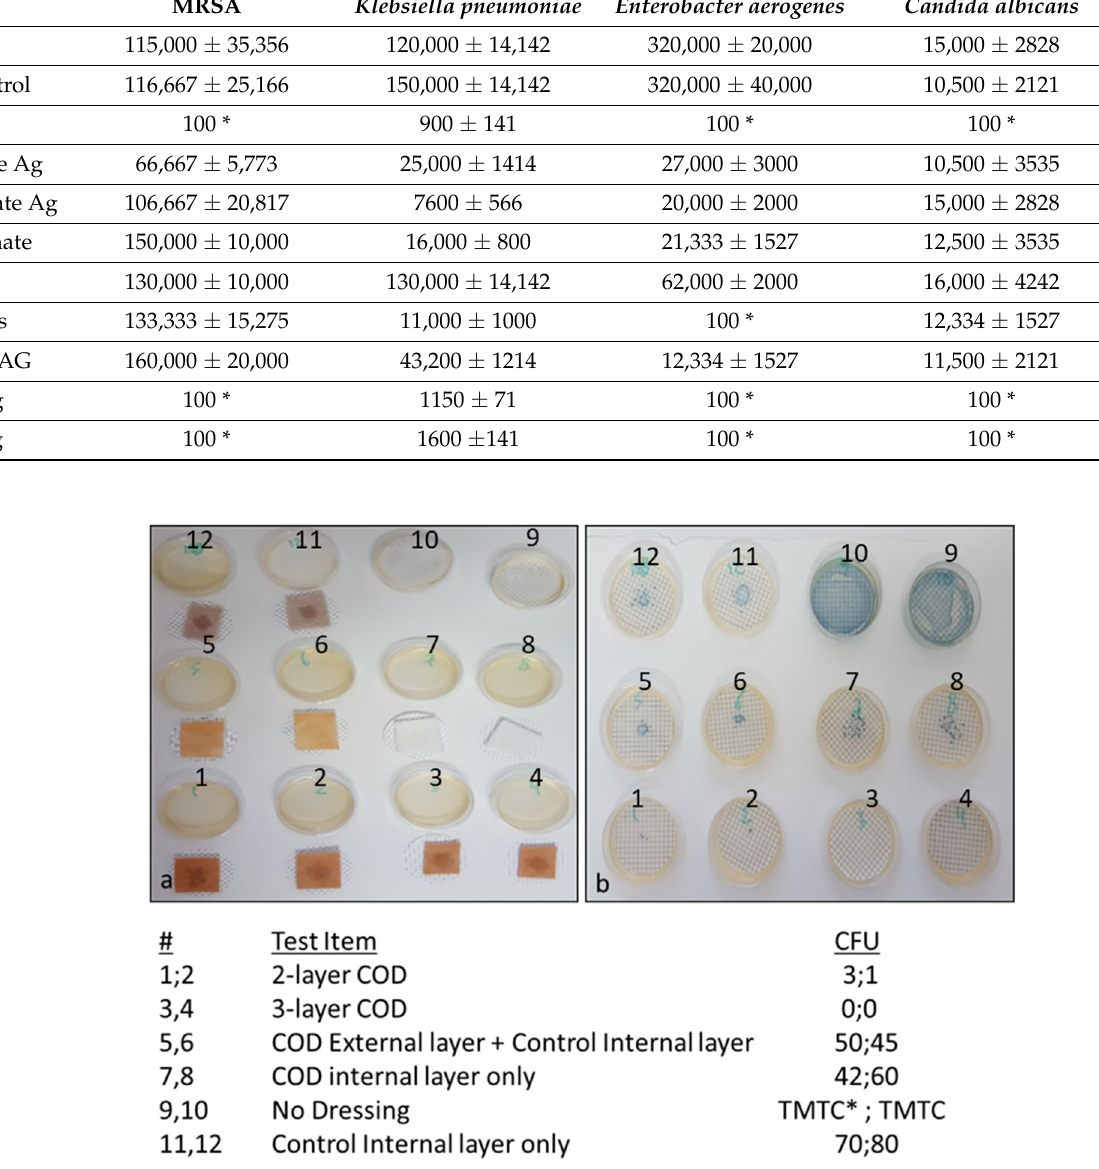
Figure 5. Reduction of bacterial passage through the COD without an adhesive contour. ( a ) The test items were placed on top of cellulose nitrate filters as detailed in the left column of the Figure and spiked with 1 mL of ~8 × 10 5 CFU of Klebsiella pneumoniae in the middle of each swatch (dark spot seen in each swatch). After 10 min, the test items were removed and the filters were placed on top of agar plates. As control of the inoculated bacterial load, 2 agar plates were inoculated with 1 mL of the Klebsiella pneumoniae stock solution (plates 9 and 10). ( b ) After overnight incubation at 37 °C, the CFU on each plate were counted. The numbers of CFU per each duplicate sample tested are shown in the right column of the Figure. TMTC: Too many to count. Figure 6. Blockade of bacterial passage through the COD with an adhesive contour. ( a )First inocu- lation of the different bacteria onto the Control and COD dressings. Agar plates were covered with swatches of the Control or COD dressings (triplicates). Each swatch was then inoculated with 0.5